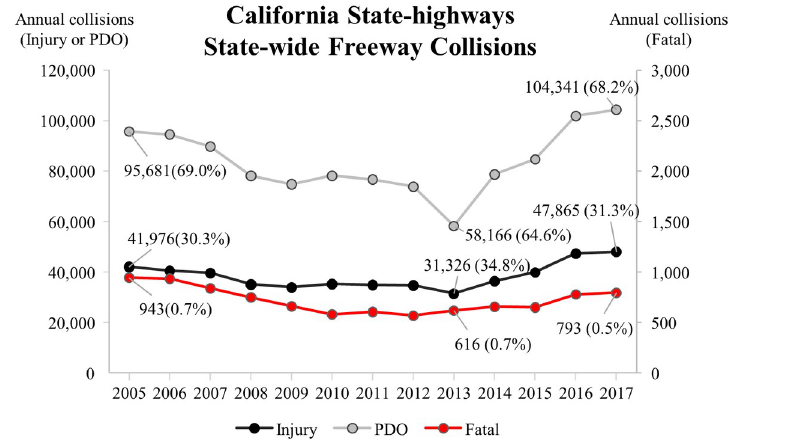
Fig 1. Annual collision trend in California from 2005 to